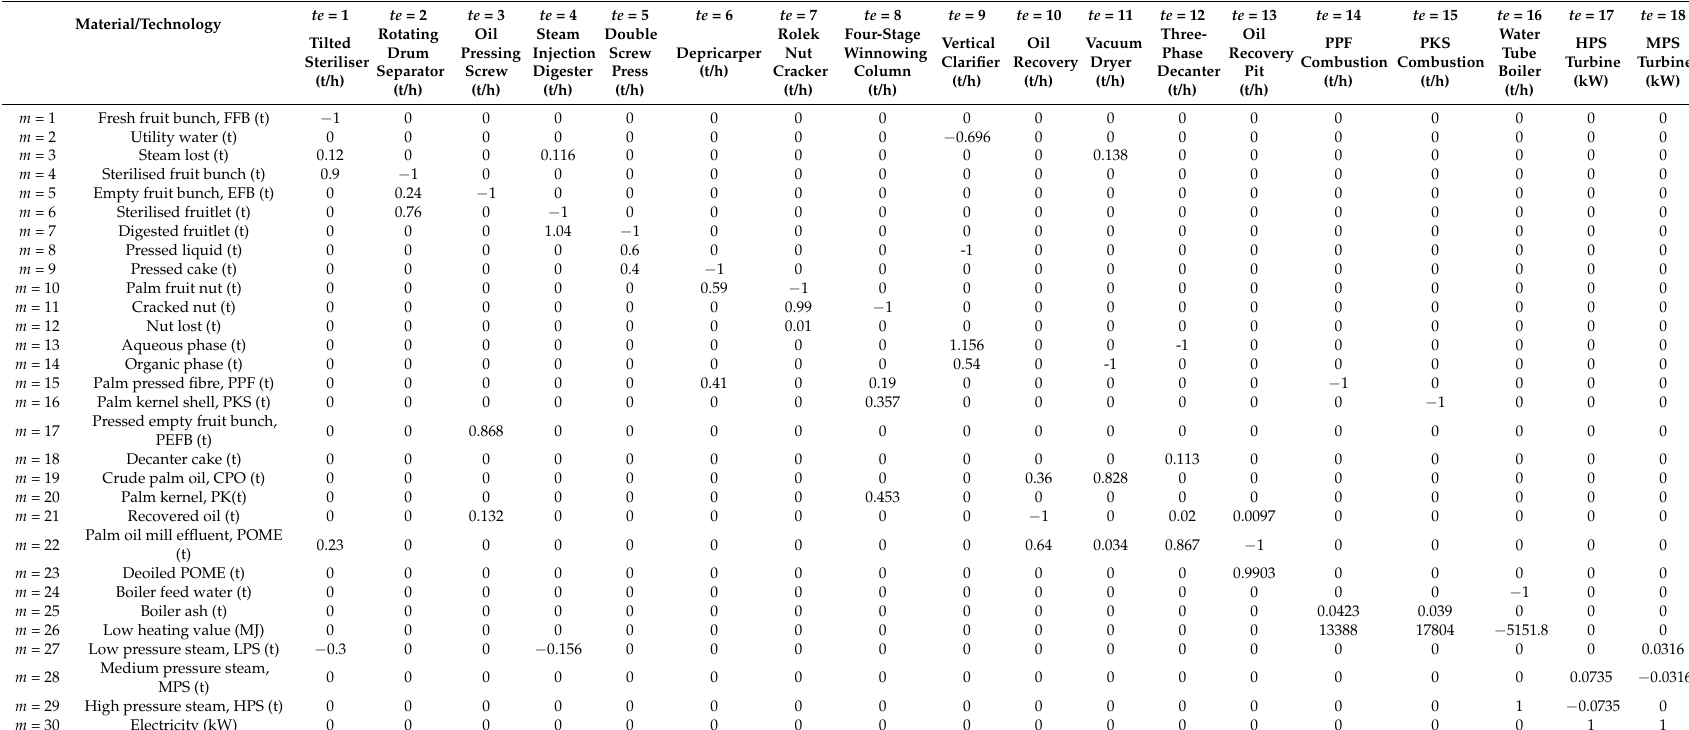
Table 5. Process matrix A for palm oil milling